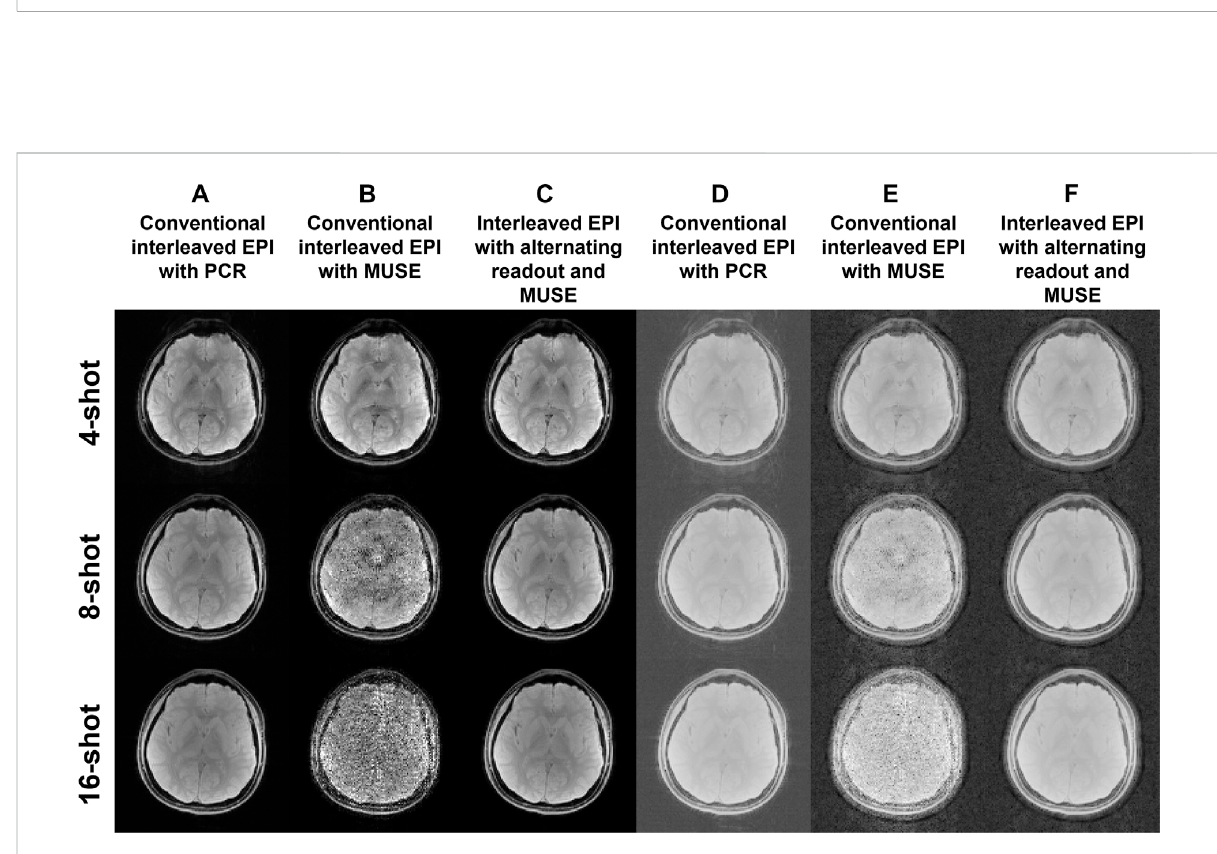
FIGURE 4 Two-dimensional single-band multi-shot GE-EPI images produced from (A) conventional interleaved EPI with PCR, (B) conventional interleaved EPI with MUSE reconstruction, and (C) interleaved EPI with alternating readout and MUSE reconstruction. (D – F) The reconstructed images corresponding to (A – C) are scaled with a factor of power of 0.2 for showing the background signal